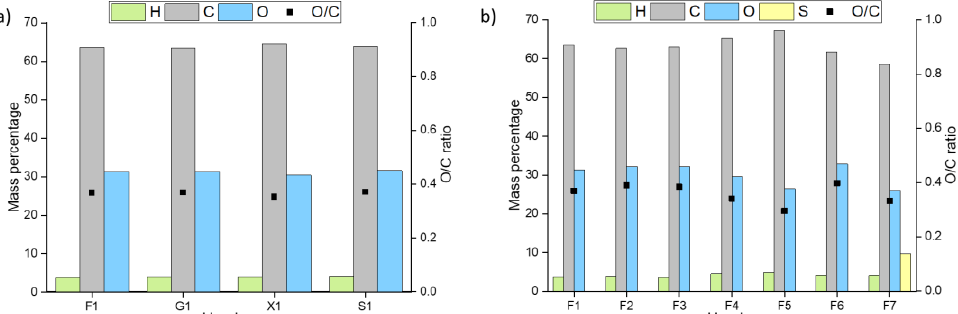
Figure 4. Elemental analysis of synthesized humins; ( a ) humins synthesized with sulfuric acid in water ( b ) humins synthesized from fructose using different acids and solvent mixtures (for elemental composition of used sugars, see Table S2).